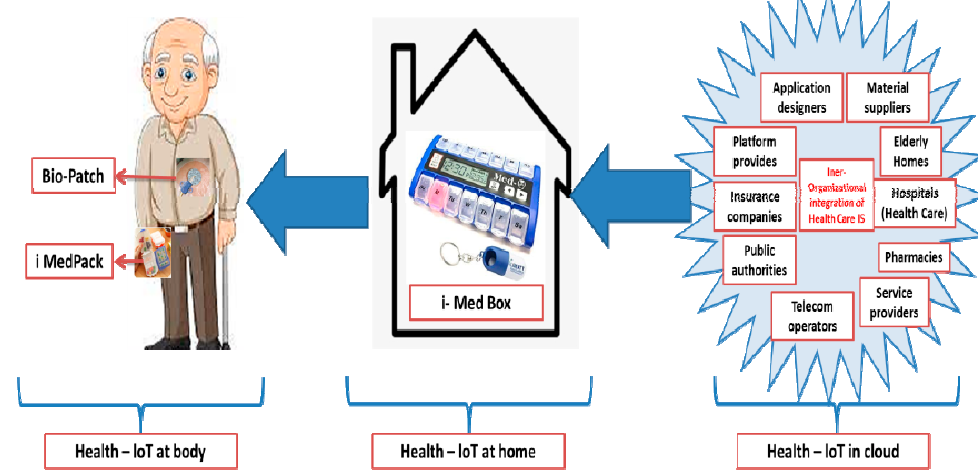
Figure 6. Integrated HIS enabled by the proposed iHome Health-IoT system.